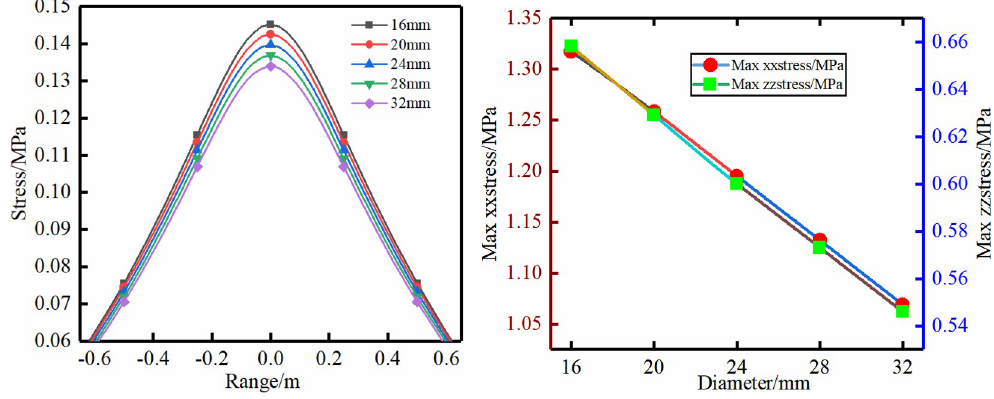
Fig 4. Different